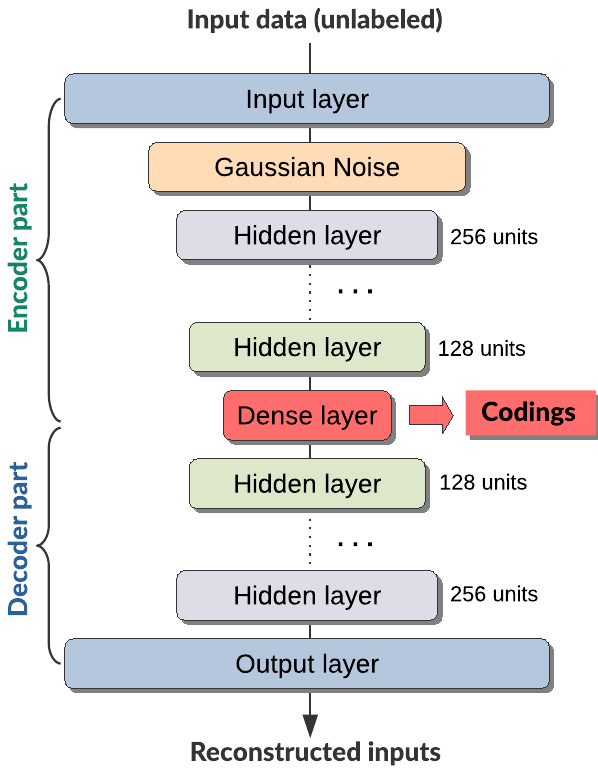
Figure 6. An overview of the undercomplete denoising stacked autoencoder